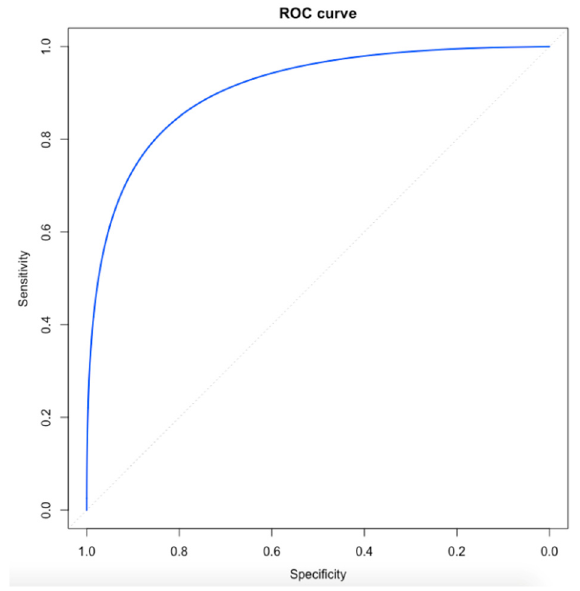
Figure 1. The ROC analysis for the G8 screening tool.